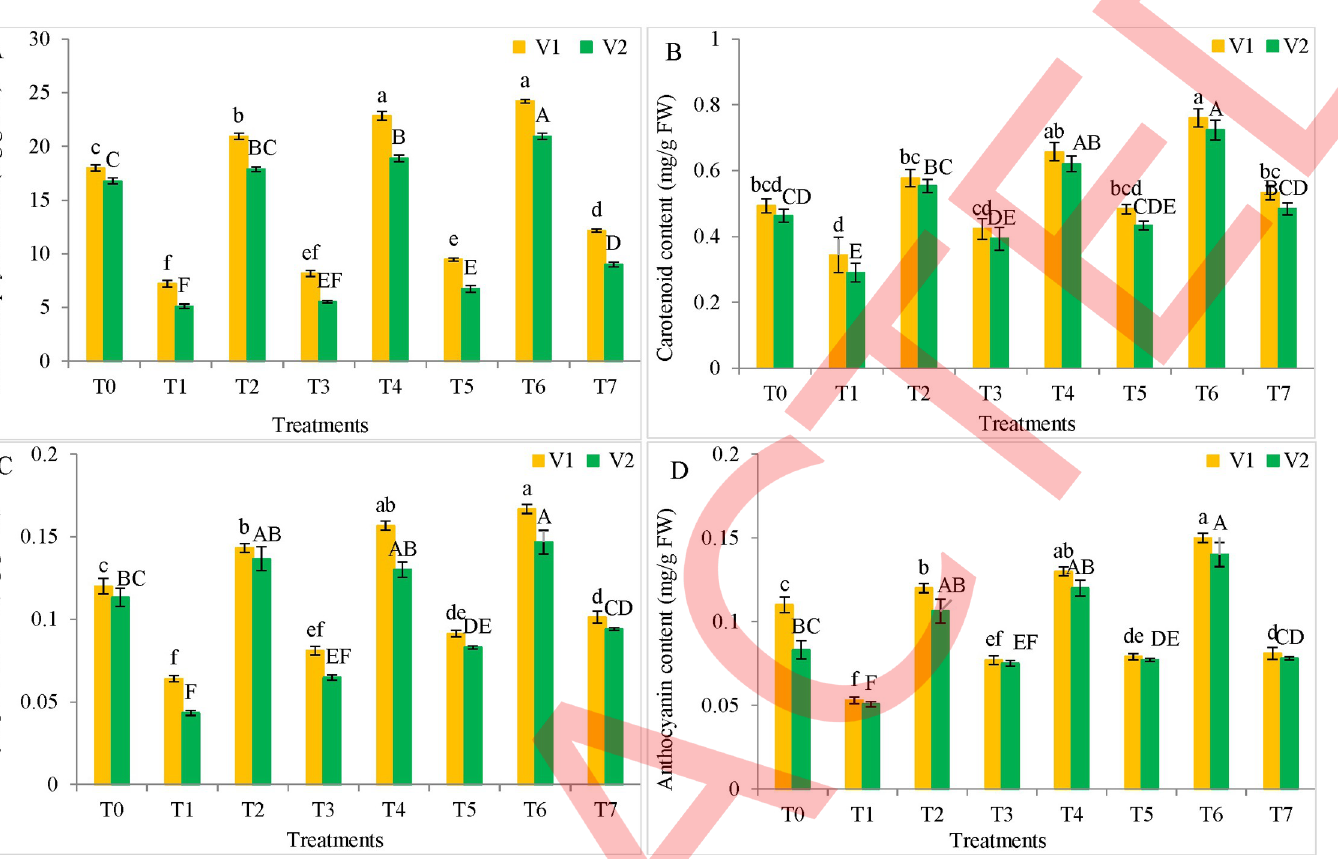
Fig 2. Effect of biochar and compost on photosynthetic pigments of Spinach under cadmium stress. (A) Total chlorophyll content, (B) carotenoid content, and (C) lycopene content, and (D) anthocyanin content of Spinach. The mean of three replicates and standard deviation are presented. Different letters show the significant difference among treatments. Treatments as mentioned in Fig